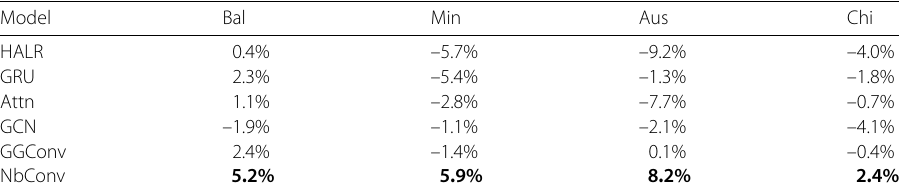
Table 11 Average relative change in F1 score using M for violent crimes over all test months (Aug-Dec) in each